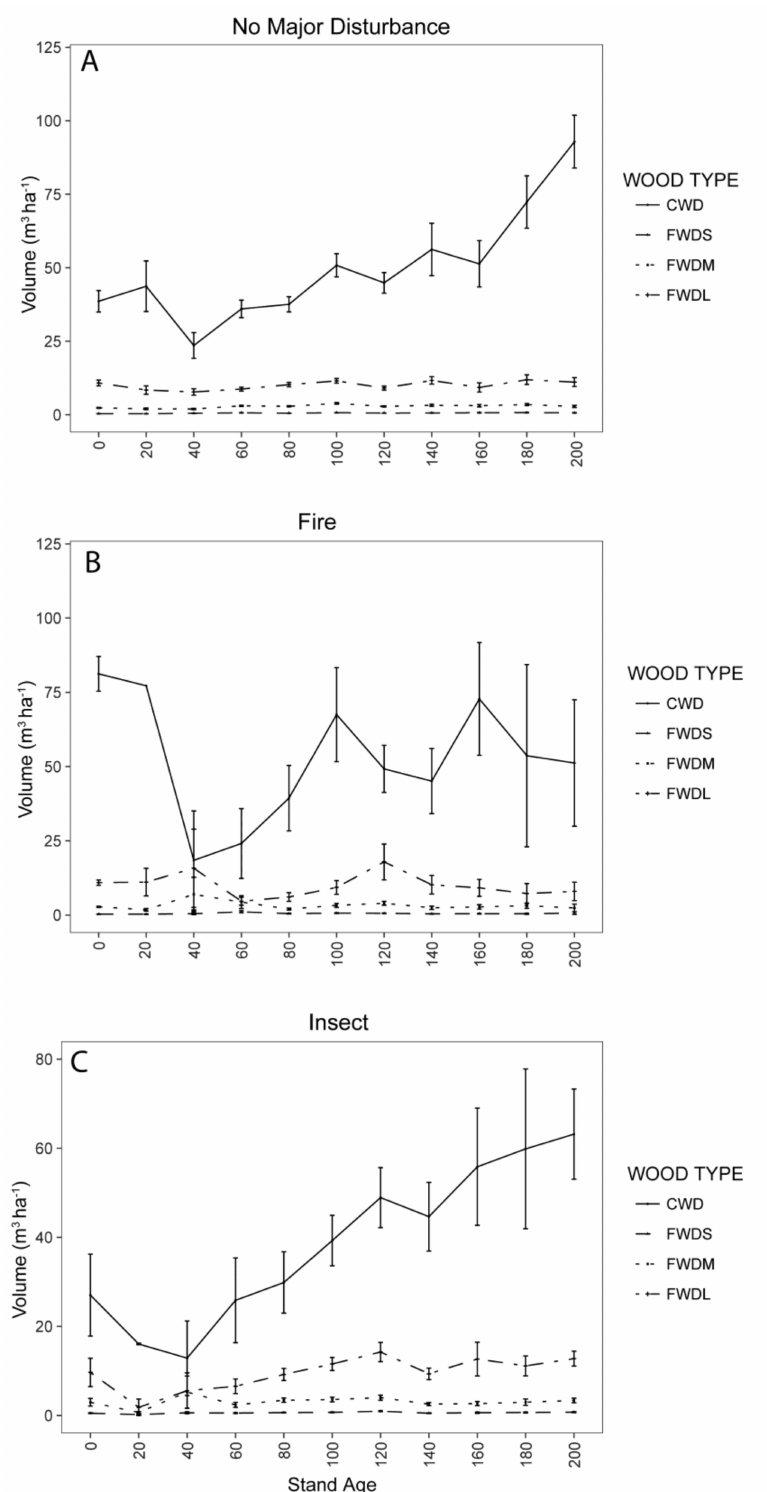
Figure 4. Mean and standard error of volume (m 3 ha − 1 ) for downed woody material (DWM) components including coarse woody debris (CWD), fine woody debris small (FWDS), medium (FWDM), and large (FWDL) across a range of stand ages for interior Douglas-fir forests with stand histories of ( A ) NMD, ( B ) fire, and ( C )